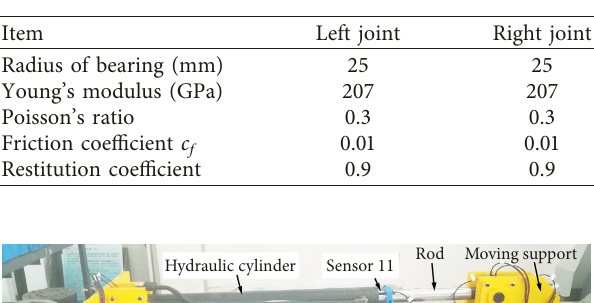
Table 2: Geometric and physical parameters of revolute clearance joints.